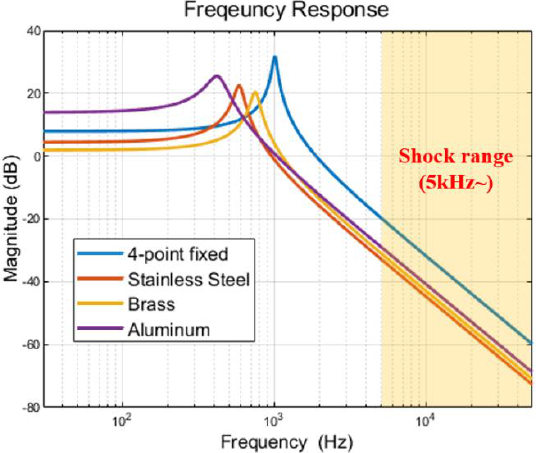
Figure 9. Frequency response between 4-point fixed isolator and stainless-steel integrated isolator.